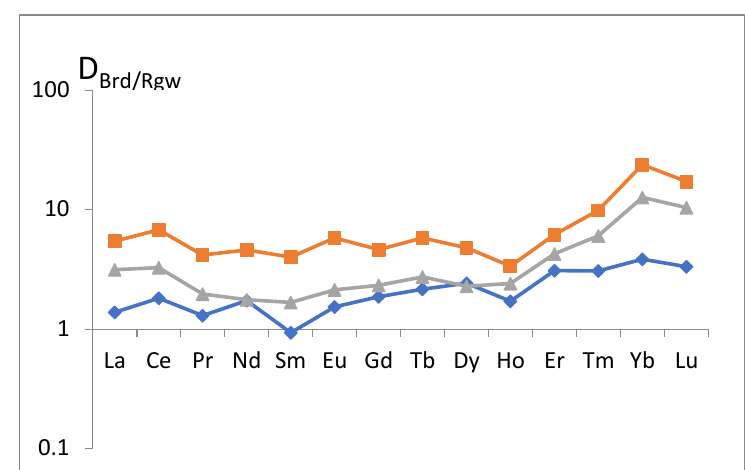
Figure 3. REE partition coefficients for bridgmanite and ringwoodite in the system ringwoodite-mixREE. Sample 3526-1, the pressure is 24 GPa and the temperature is 1600 °C.